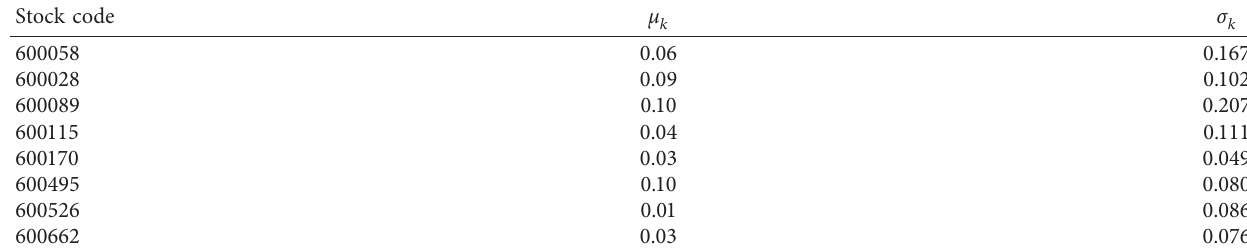
Table 1: The possibility distribution of returns.